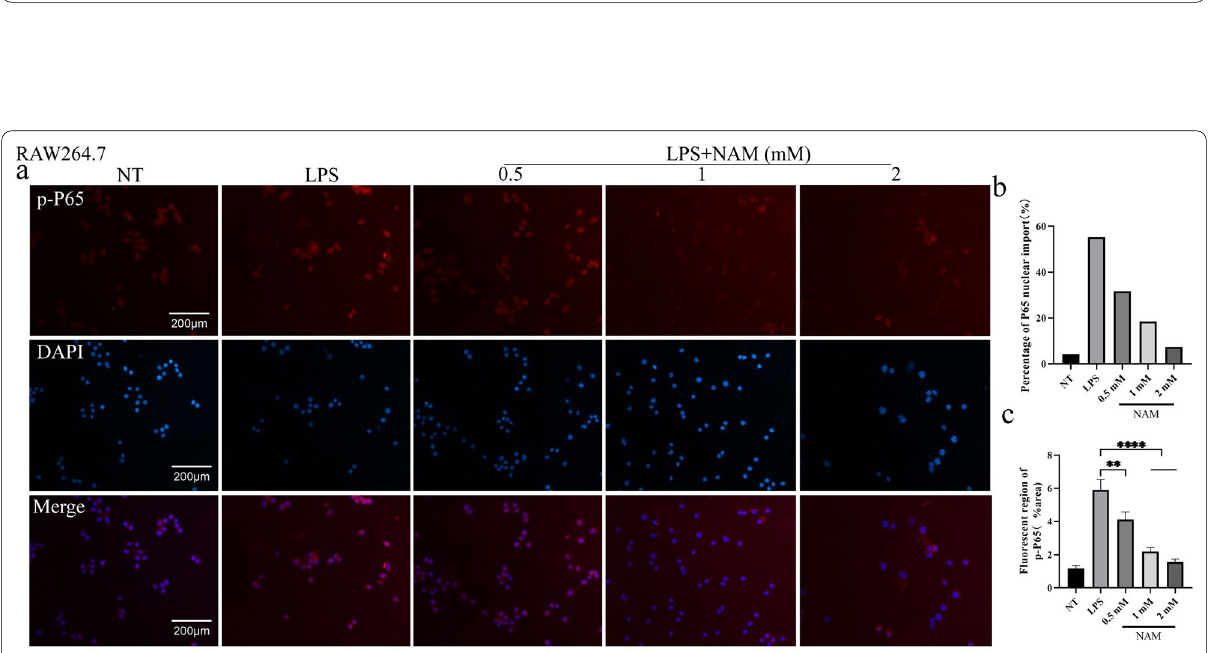
Fig. 7 Effect of NAM on AKT/NF-κB signaling pathway in RAW264.7. The experiment was divided into 5 groups: NT, LPS, LPS and LPS 2 mM. a – d NAM was added 1 h before LPS was added, and the total protein of the cells was collected after LPS treatment for 3 h. The + phosphorylation of AKT, IκBα and P65 were detected by western blot. The values are presented as the mean